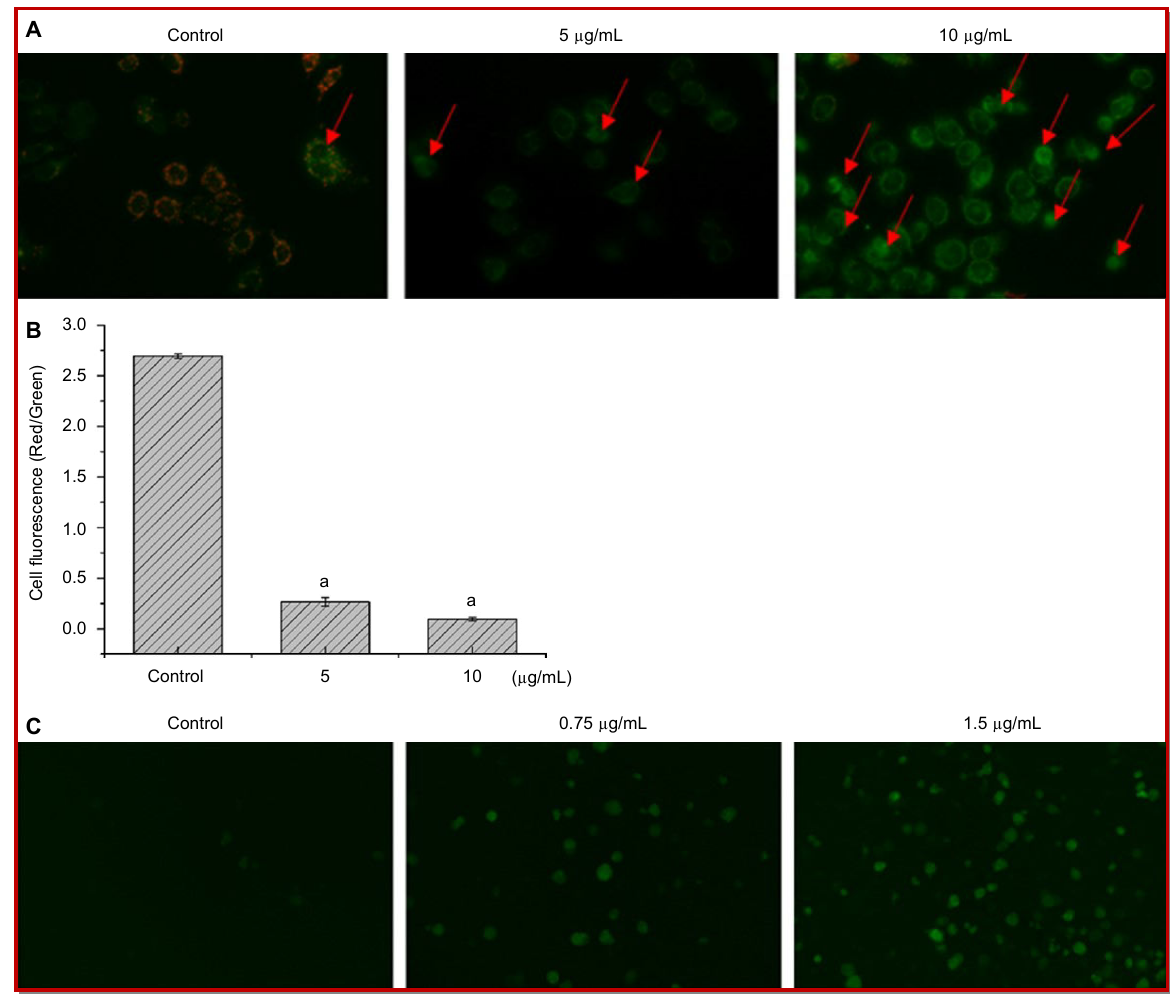
Figure 4: Effect of compound 34 on mitochondrial membrane potential ( ΔΨ m) levels and ROS generation in MCF-7 (A) MCF-7 cells were treated with different concentrations of compound 34 for 24 hours and the mitochondrial membrane potential was detected by JC-1 staining; (B) The fluorescence quantitative results of JC-1 staining, results are expressed as the means ± SD; a p<0.01 compared with control group; (C) MCF-7 cells were incubated with various concentrations of compound 34 for 12 hours and a fluorescence microscope captured the ROS production using DCFH-DA